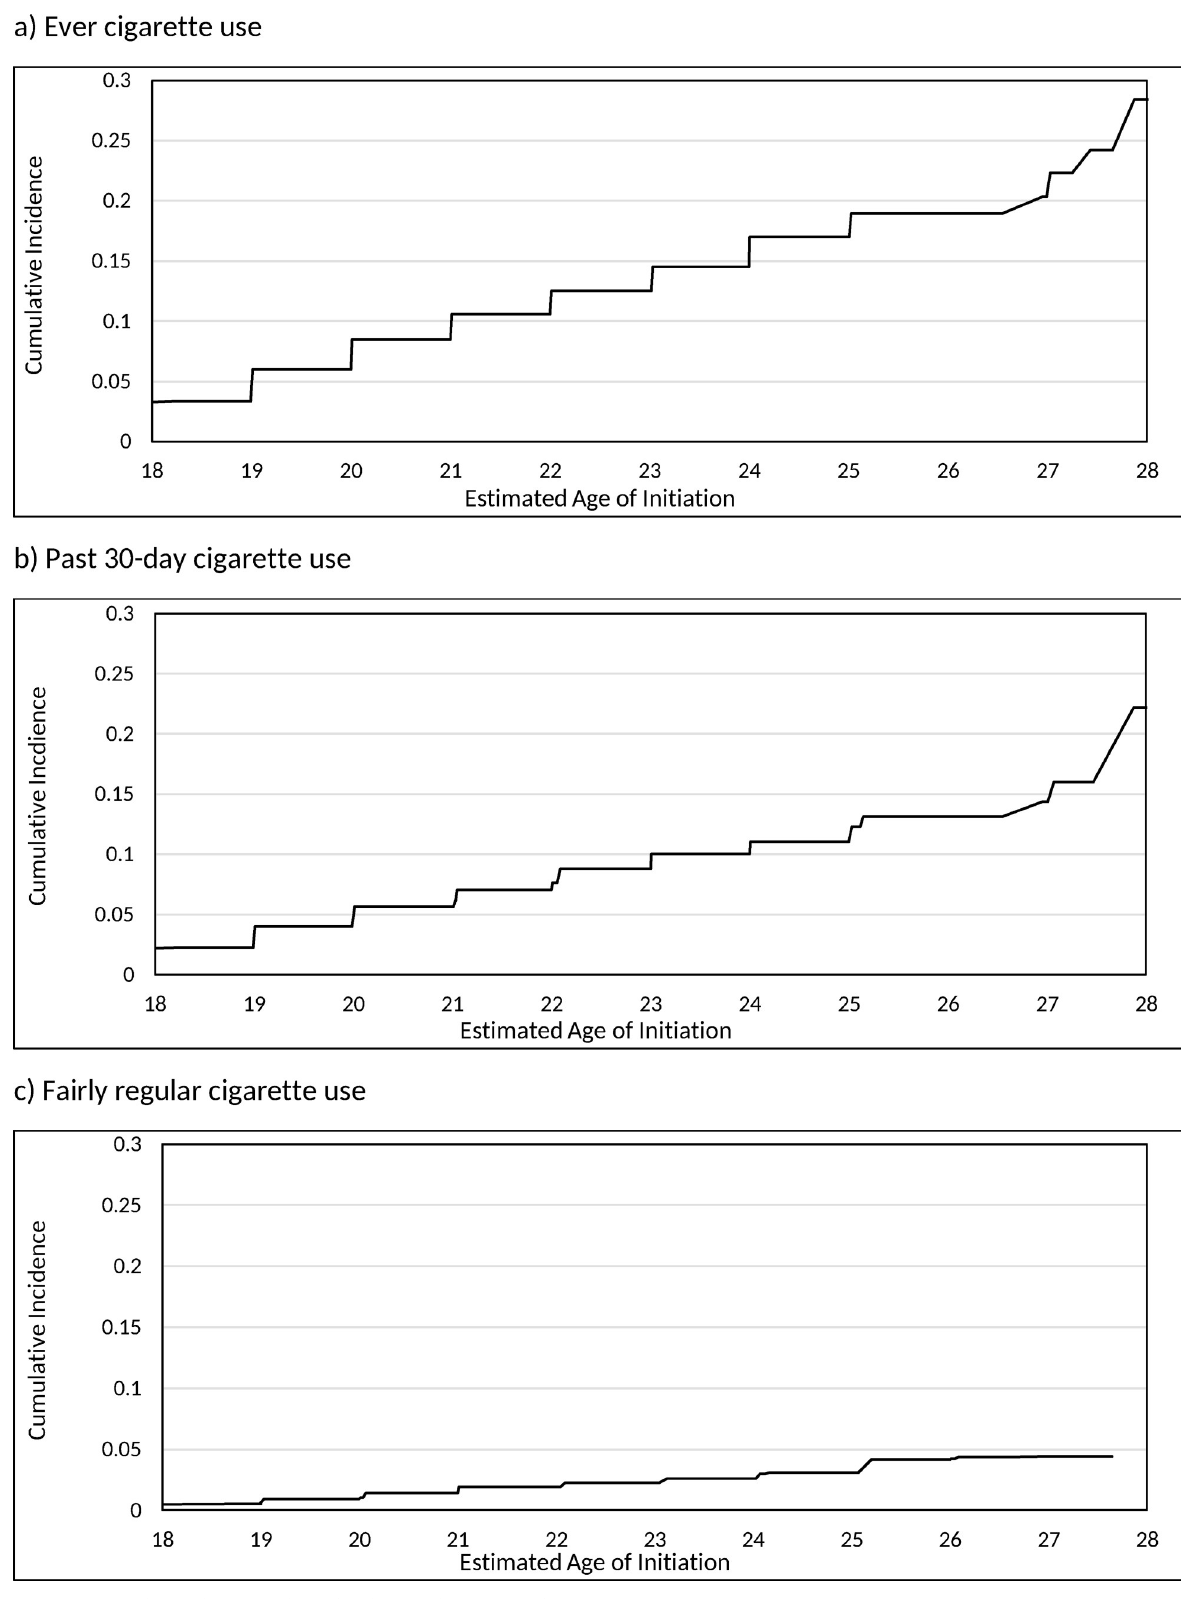
Fig 2. Estimated cumulative incidence for the age of initiation of cigarette outcomes. https://doi.org/10.1371/journal.pone.0251246.g002 PLOS ONE | https://doi.org/10.1371/journal.pone.0251246 May 5,